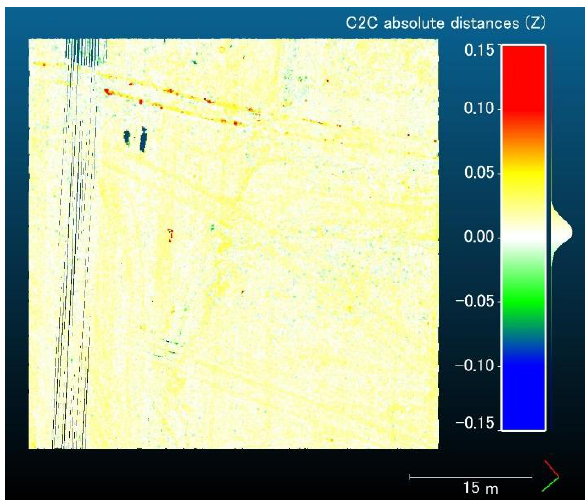
Figure 8. Differences in the terrestrial laser scanner